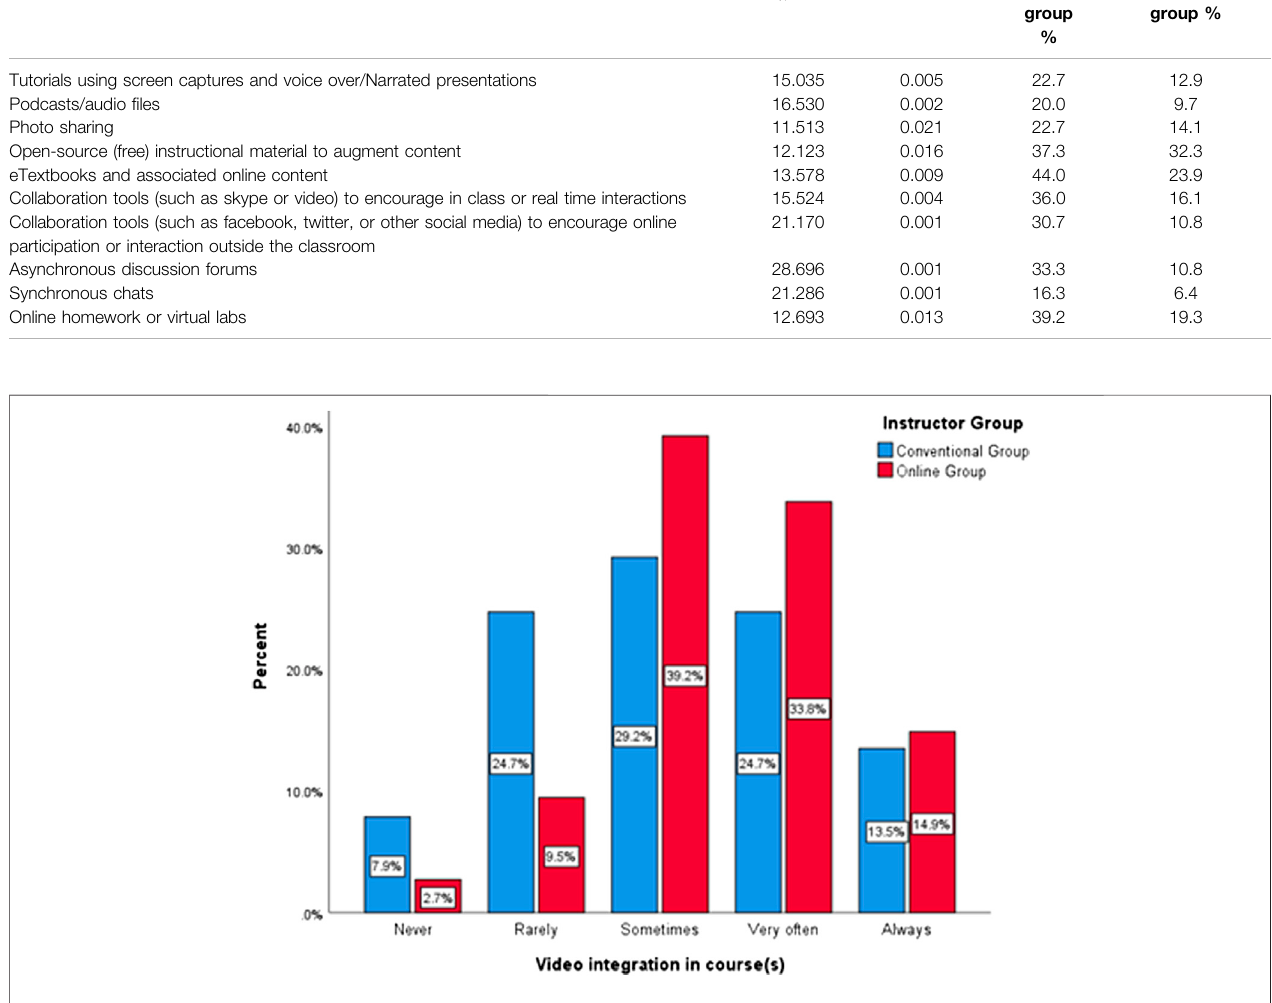
Table 1 ), we fi nd signi fi cant differences favoring the Online